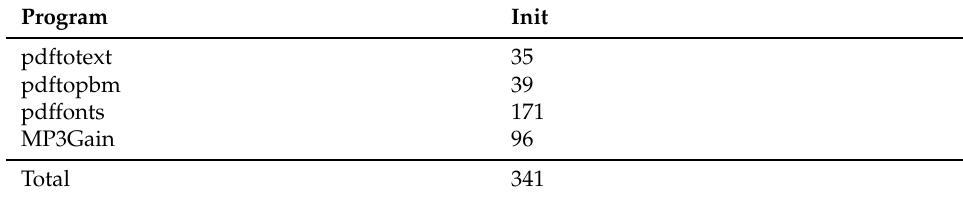
Table 6. Number of unique crashes (80 + 0).